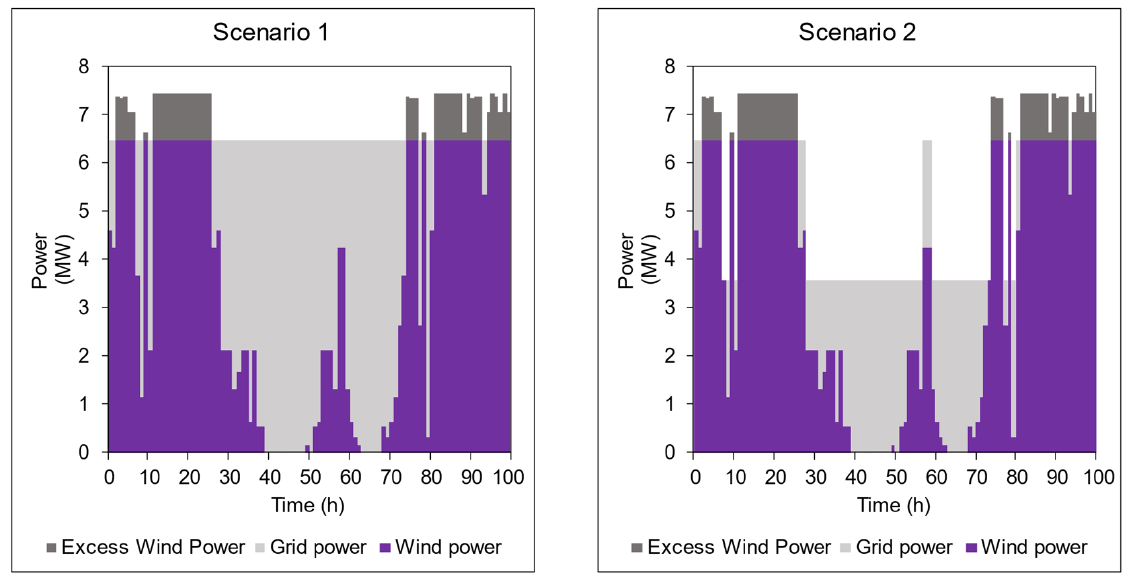
Figure 6. Sample of power usage distribution for Scenario 1 and Scenario 2 during the same 100 h duration in Figure 5. Table 6. Production and power comparison for the two scenarios.